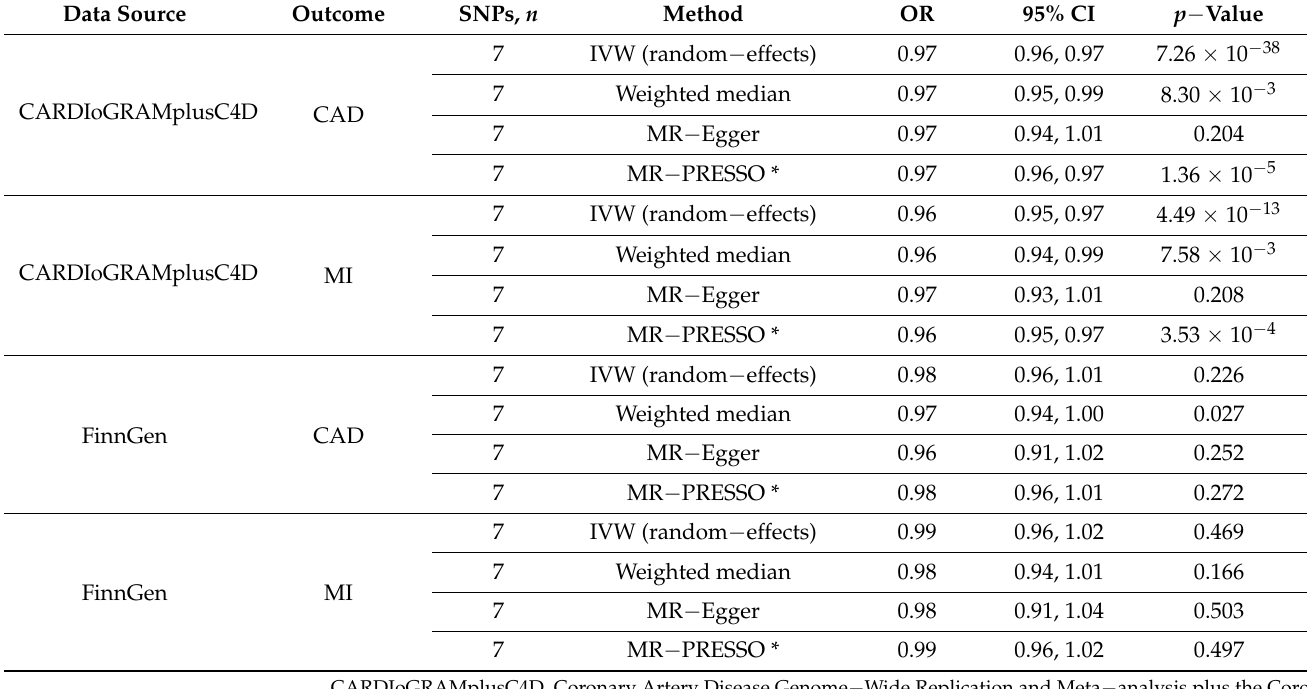
Table 2. Association of genetically predicted circulating TIMP3 levels with CAD and MI risk in complementary analyses.